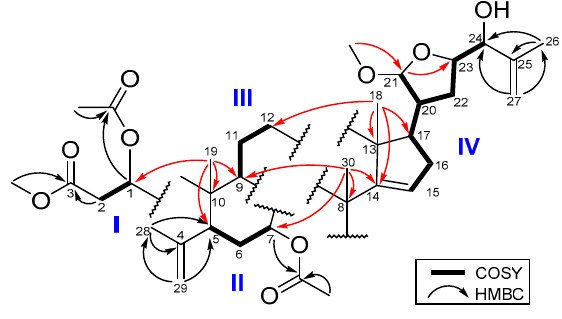
Figure 2. COSY and HMBC of 1 .